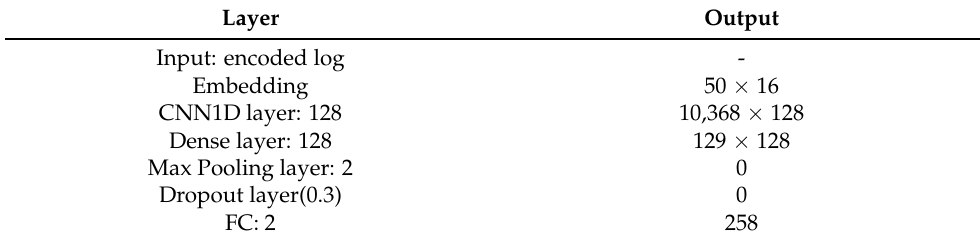
Table 1. Specific parameters of the CNN1D model used in our study.